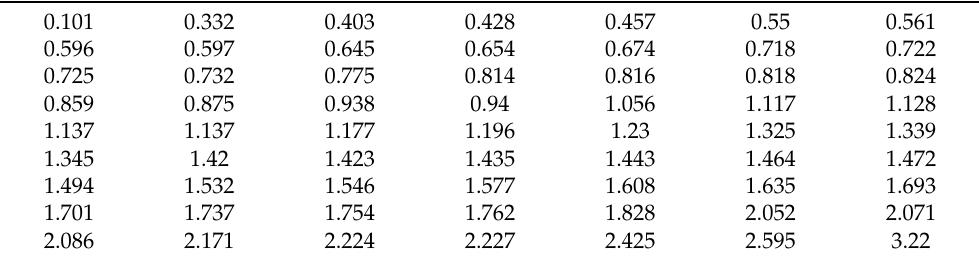
Table 11. Breaking strength of a single carbon fiber with a gauge length of 10 mm.